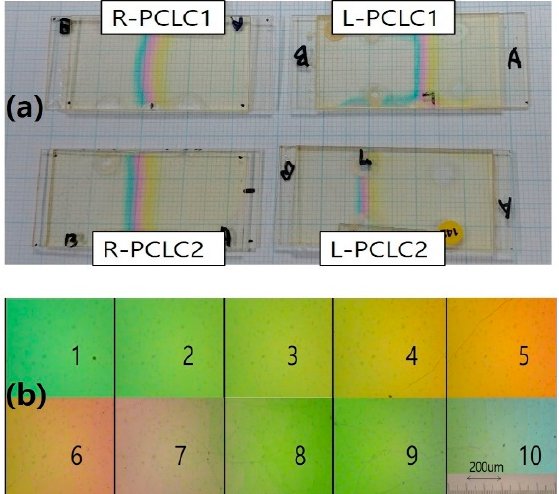
Figure 3. ( a ) Photographs of well-developed wedge cells of R-PCLC1, R-PCLC2, L-PCLC1, and L-PCLC2 placed on a plotting paper, and ( b ) Juxtaposition of ten polarized microscope photographs at different spatial positions of the R-PCLC1 cell, respectively.